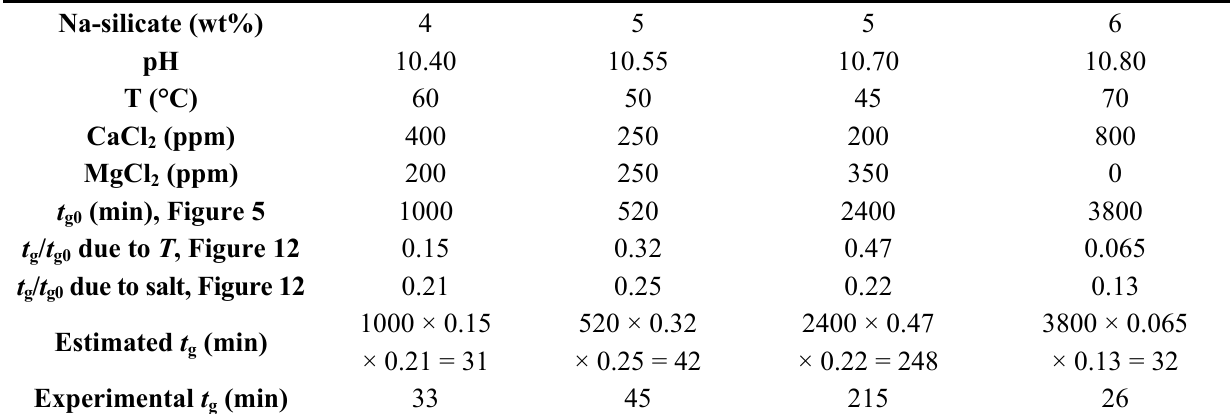
/ t ) as a function of the reciprocal absolute g g0